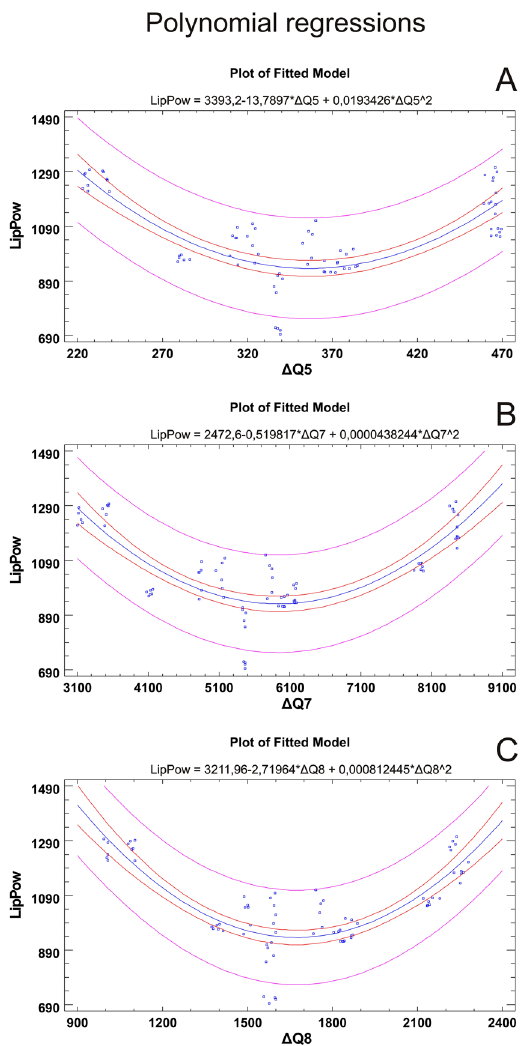
significant group of variables. The inner limits provide 95% confidence intervals for the mean value of y at any selected x. The outer lines are 95% prediction limits for new observations. Equations were reported for each fitted model. LipPow = Lipophilic antioxidant